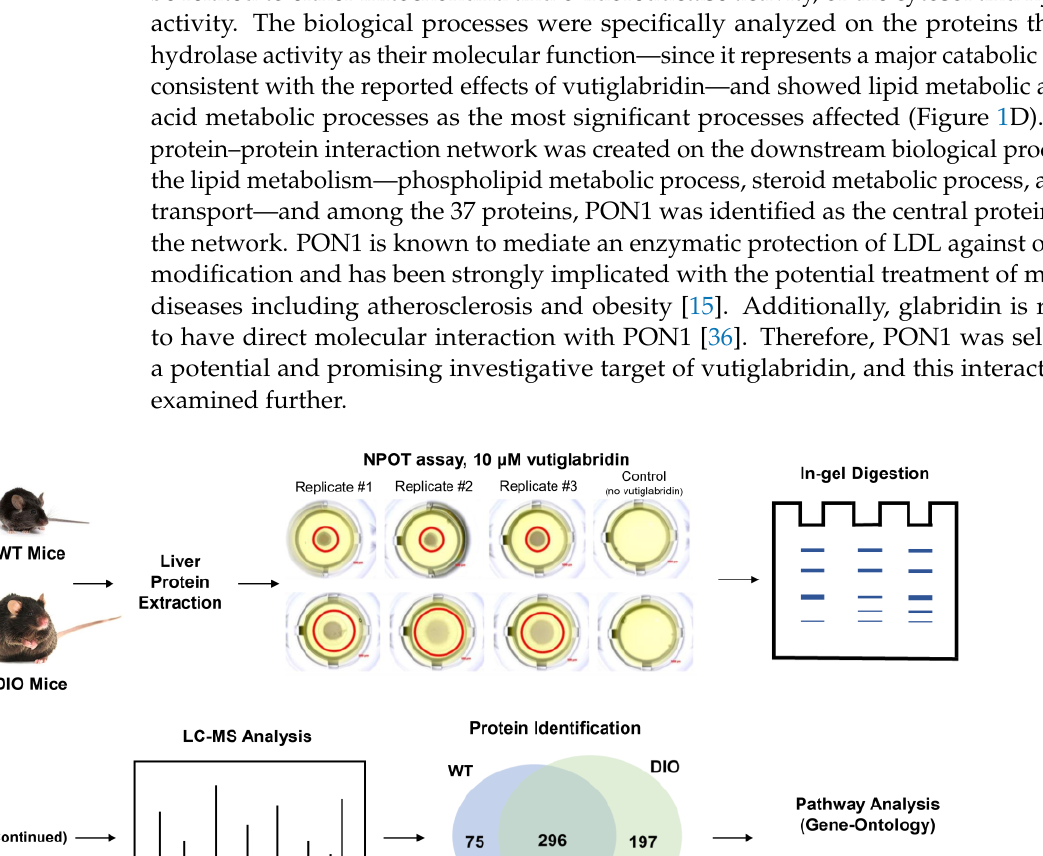
Figure 1. PON1 is identified as a potential target of vutiglabridin through NPOT assay. ( A ) Schematic representation of the Nematic Protein Organization Technique (NPOT) analysis of vutiglabridin on protein homogenates from the liver of healthy wild-type (WT) and diet-induced obesity (DIO) mice with validation by biophysics methods. In total, 568 proteins were identified as potentially interacting proteins, and 296 proteins (52%) were present in both conditions. ( B ) Ranked list of Gene Ontology (GO) cellular components and ( C ) molecular functions of the